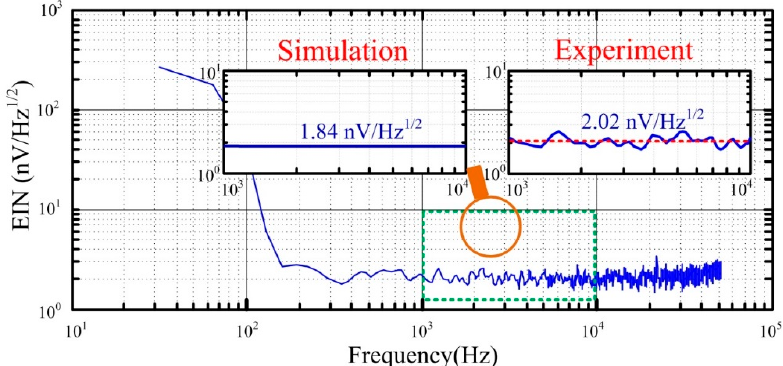
Figure 13. Equivalent input noise of ACS with air-core coil B.